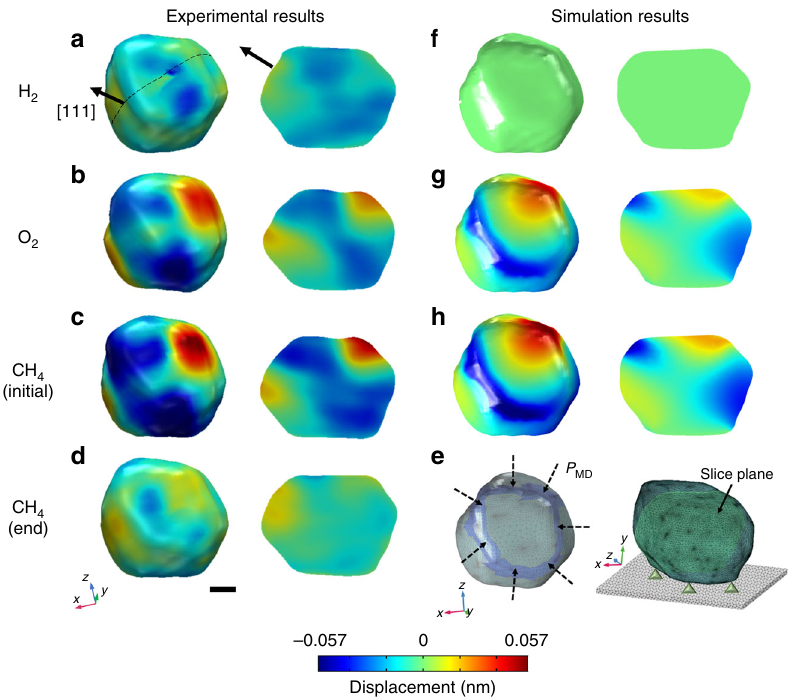
Fig. 4 Displacement distribution from the experiments and fi nite element analysis (FEA). a – d 3D reconstructed images (left) and sliced images (right) including lattice displacements at (111) with 25% isosurface amplitude of a 220 nm Pt nanocrystal under each of the four gas environments for Fig. 1a, b, d, f, respectively. Red (positive sign) indicates the projected displacements along the [111] direction and blue (negative sign) implies the opposite direction. These 3D images show lattice contraction along the edges and corners owing to adsorption of oxygen atoms and methane oxidation. The cross-sections show that the distortion propagates deep into the interior of the Pt nanocrystal and is released after catalytic methane oxidation. e Images on the left show meshing of BCDI result. RMD-derived reaction-induced pressure ( P MD ) is applied to the region shaded in blue. Images on the right show the Dirichlet constraint of zero displacement, included in the FEA. The slice plane used for f – h is also shown. f – h The FEA predictions for the Pt nanocrystal response to adsorption induced external force obtained from RMD corresponding to a – c . Crystal and slice planes are colored by the [111] projected displacement. Scale bar corresponds to 50